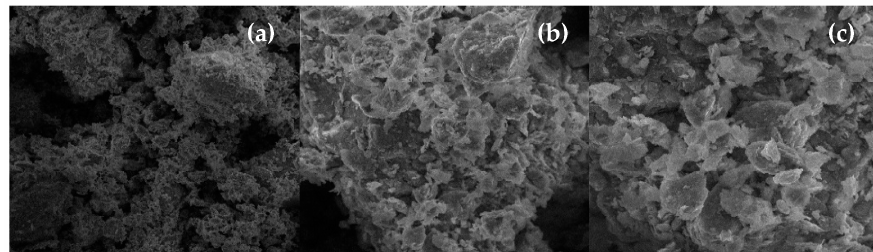
Energies 2023 , 16 , x FOR PEER REVIEW 11 of 35